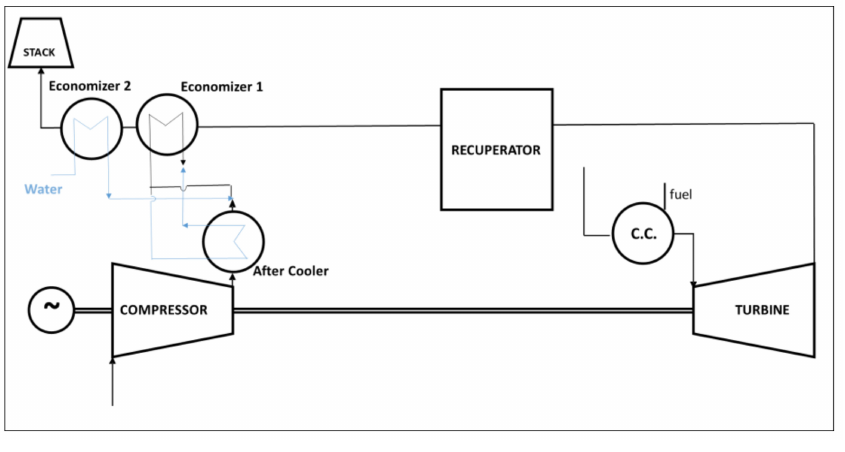
Figure 6. REVAP layout